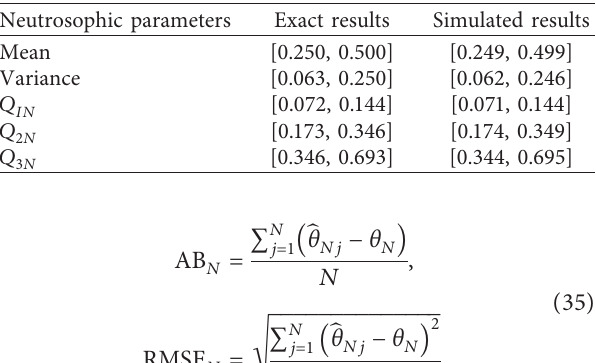
Table 1: Comparisons of simulated versus analytical